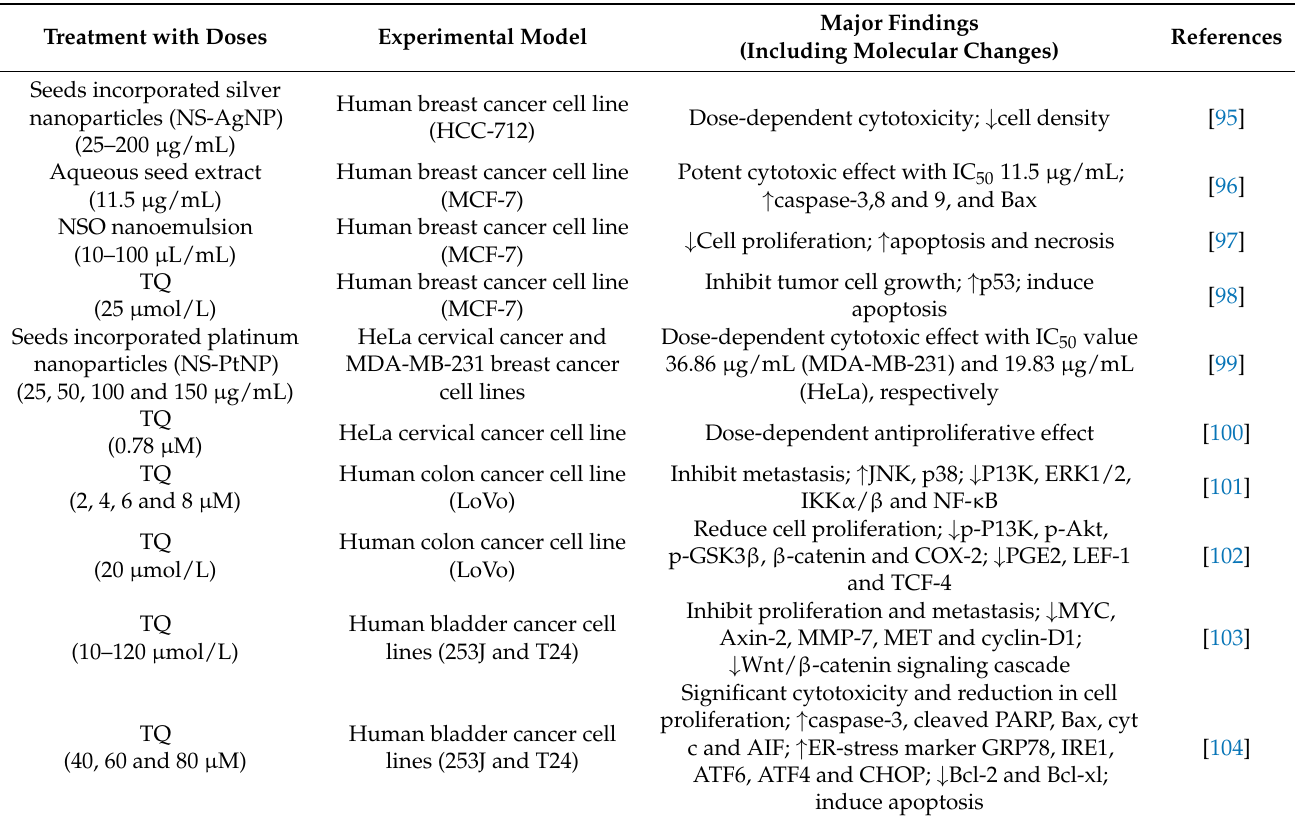
Table 2. Comprehensive summary on the anticancer effects of black